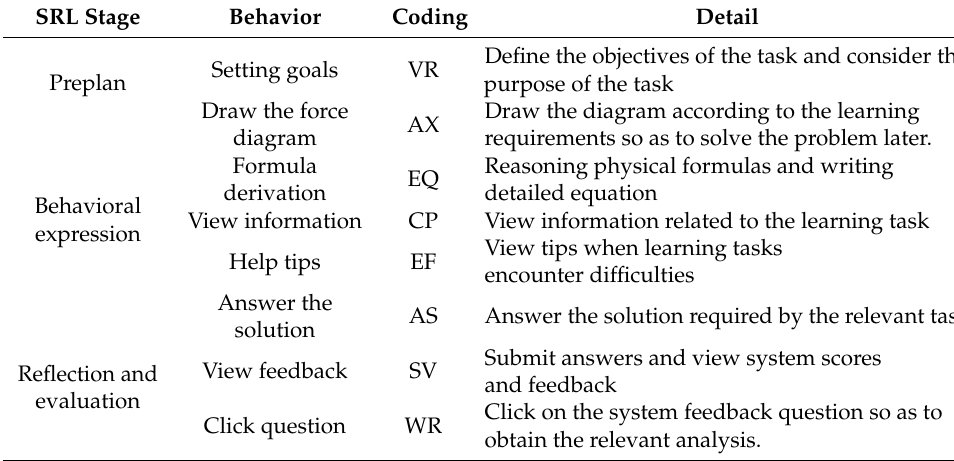
Table 1. SRL behavior coding